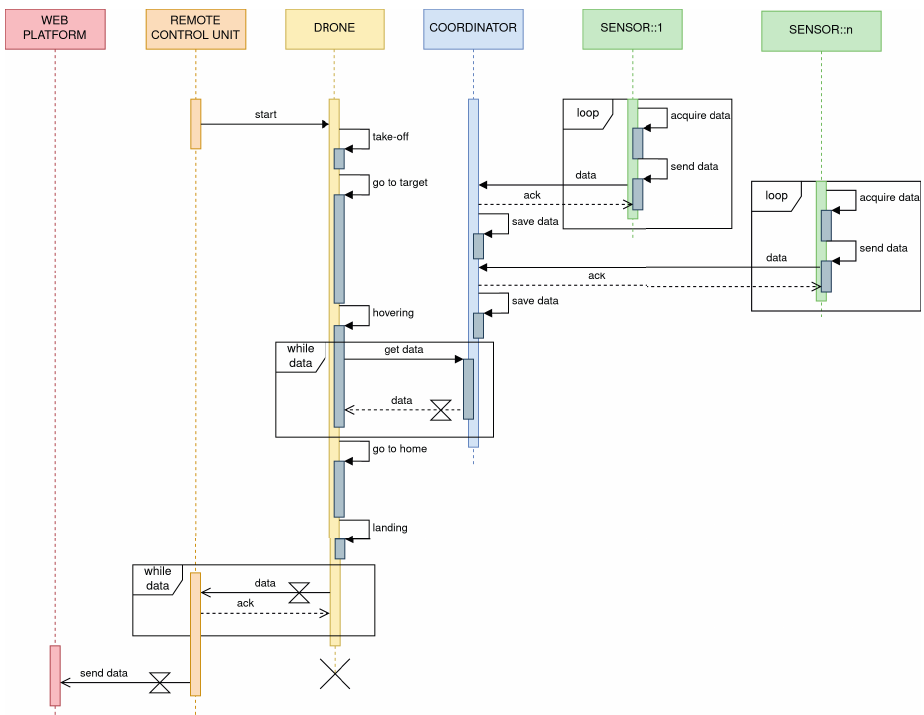
Figure 2. Sequence